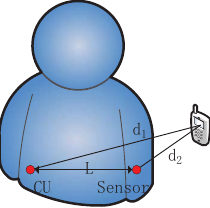
Figure 1. Illustration of the setting for received signal strength (RSS) ratio in